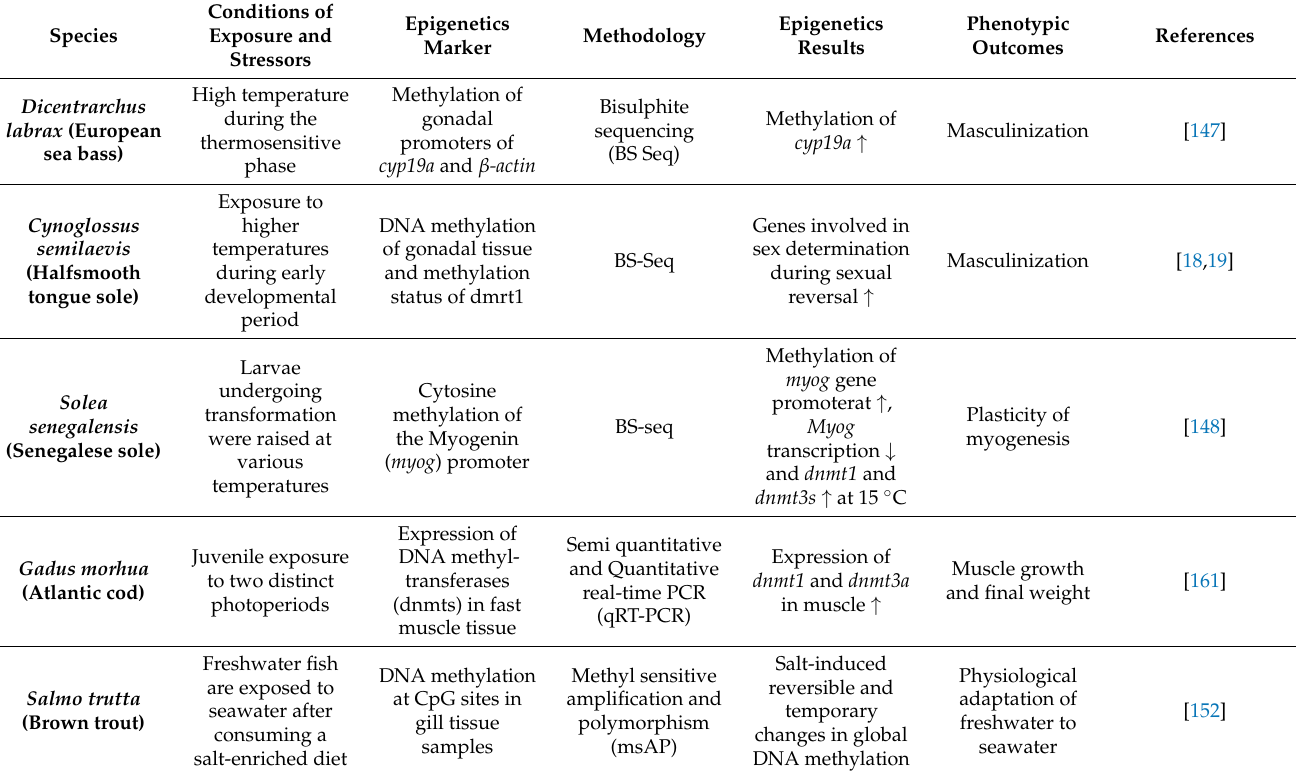
Figure 4. A diagram depicting the potential applications of epigenetics for modulation of reproductive performance. ( a ) Environmental cues can alter gene transcription via epigenetic mechanisms; ( b ) DNA methylation, histone modifications, and non-coding RNA action resulting in phenotypic changes; ( c ) outcomes of epigenetics in phenotypic traits from early to later life stage. Table 1. Epigenetic modifications effects on the reproductive performances of commercially important farmed fishes. Symbol: no change ( → ); increase ( ↑ ); decrease ( ↓ ) versus controls.